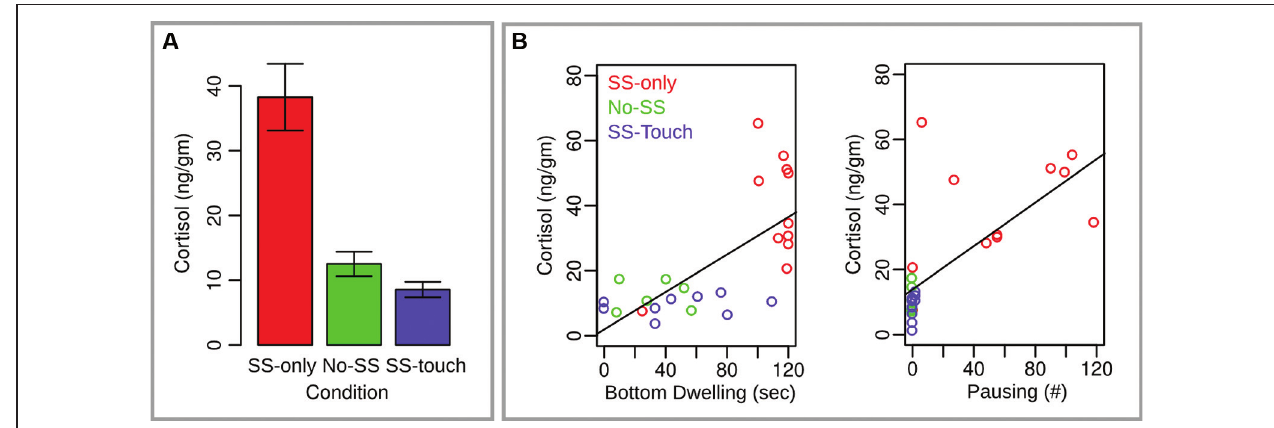
FIGURE 2 | Cortisol measures for Experiment 1 . (A) Mean cortisol values across conditions. Error bars reflect the standard error of the mean. (B) Scatter plots with regression lines indicating the relationship between cortisol and two fear behaviors, bottom dwelling and